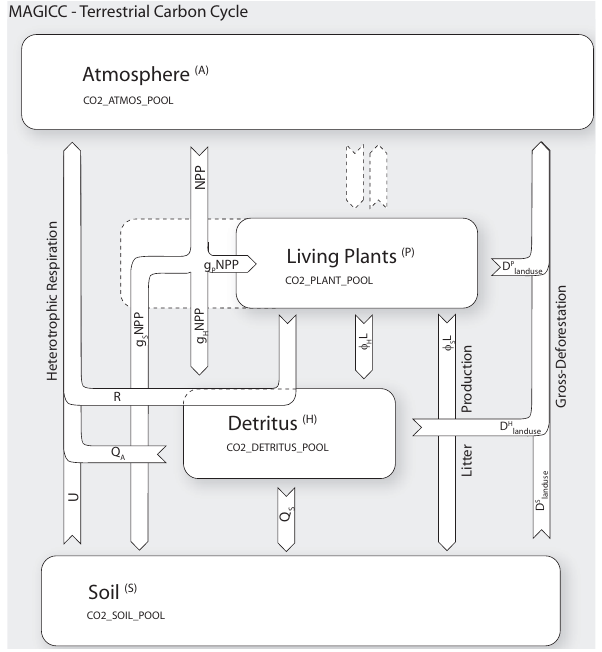
Fig. A2. The terrestrial carbon cycle component in MAGICC with its carbon pools and carbon fluxes. For description of the pools and fluxes, including the treatment of temperature feedbacks and CO 2 fertilization, see Sect.